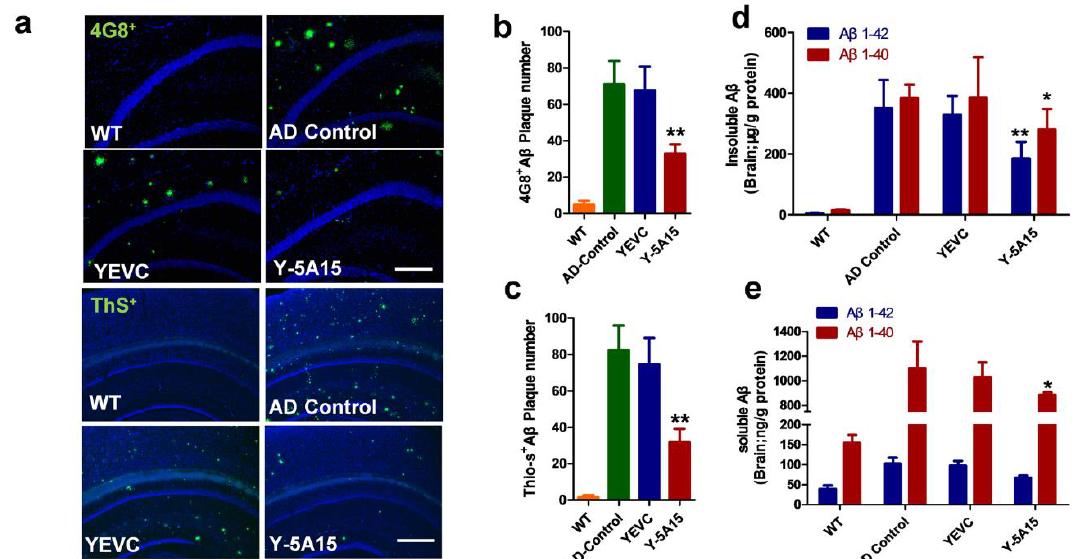
Figure 4. Y-5A15 immunization decreased cerebral amyloid- β (A β ) peptide levels in the brains of APP / PS1 transgenic mice. ( a ) Representative microscopic images of brain sections from di ff erent groups. Sections were stained with the anti-human A β antibody 4G8 (Green) and thioflavin S (ThS), counterstained with DAPI (blue) to detect nuclei. The number of 4G8-positive ( b ) and ThS-positive plaques ( c ) were quantified in the hippocampus (Hip) and cortex (Ctx) by IpWin5 software. ( d ) ELISA analyses of insoluble human A β 40 and A β 42 in the brains. ( e ) ELISA analyses of soluble human A β 40 and A β 42 in the brains. Compared with AD control, * p < 0.05, ** p < 0.01, Student’s t -test, n = 6 mice per group. Scale bar is 200 μm.